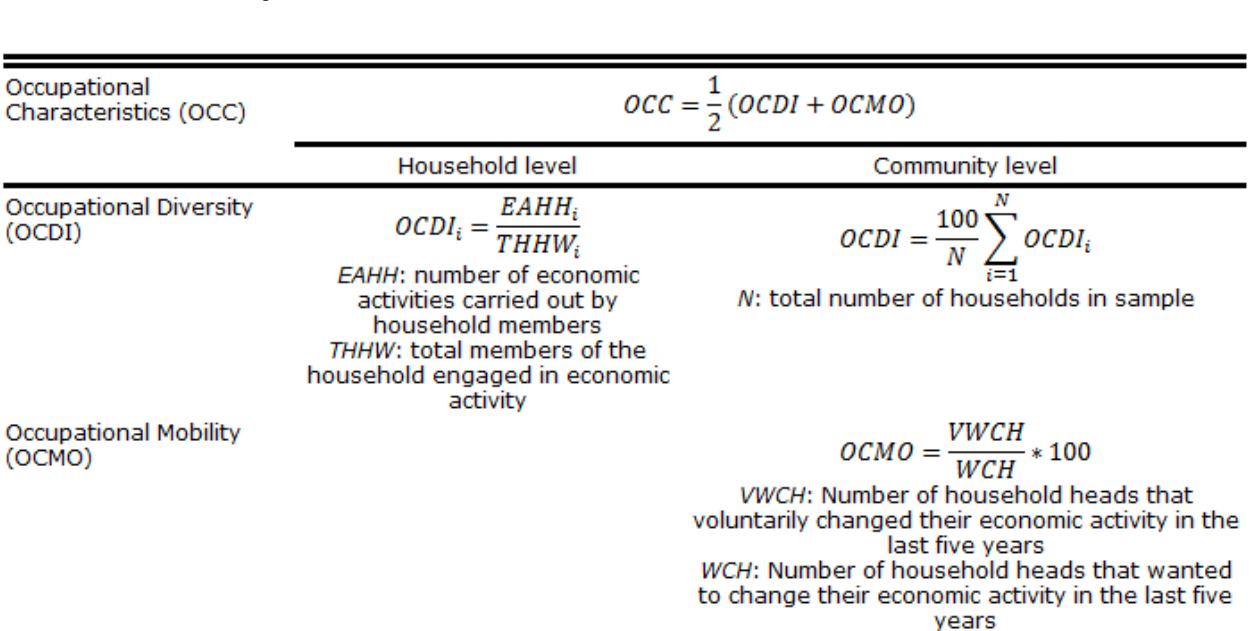
Table 3 . Calculation of occupational characteristics indicator and